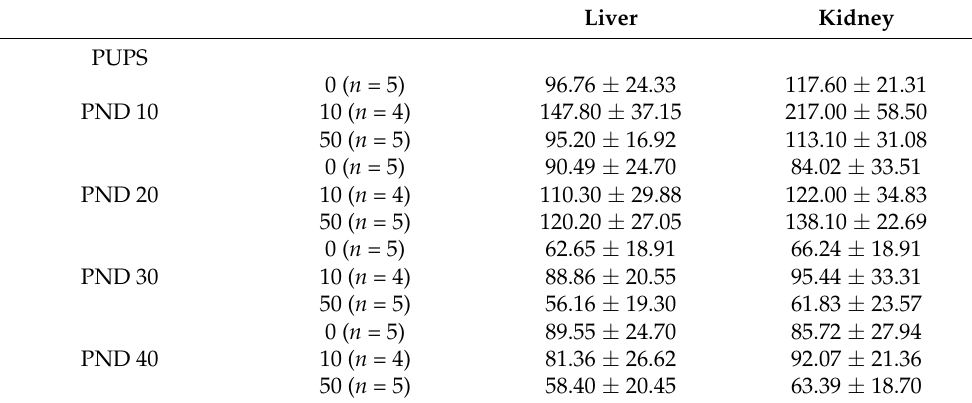
Table 6. Metallothionein from different organs of pups’ rats exposed to different doses (0, 10, and 50 μ g Hg 2+ /mL) of HgCl 2 as described in Tables 1 and 3, respectively.